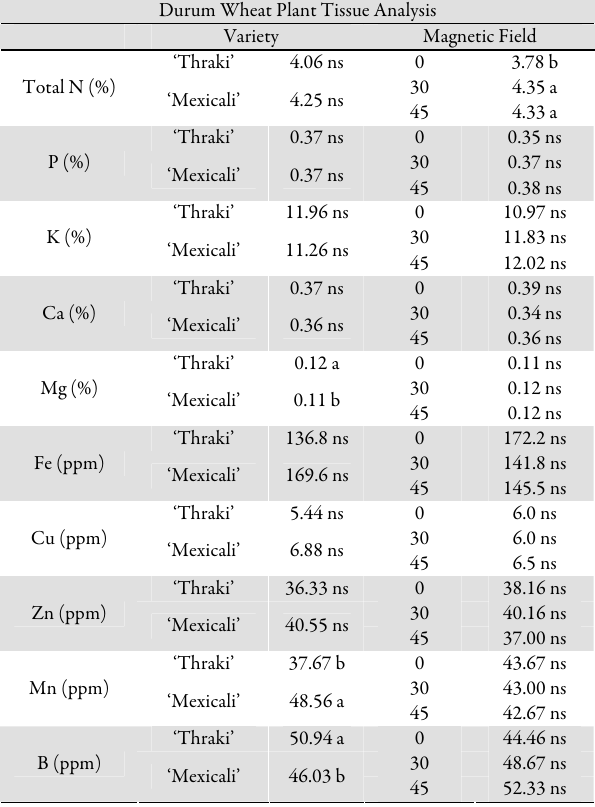
Table 1. Pulsed electromagnetic field and variety effect on nutrient absorption of two durum wheat varieties. Seeds have been treated for 0 (control), 30 and 45 minutes with magnetic field